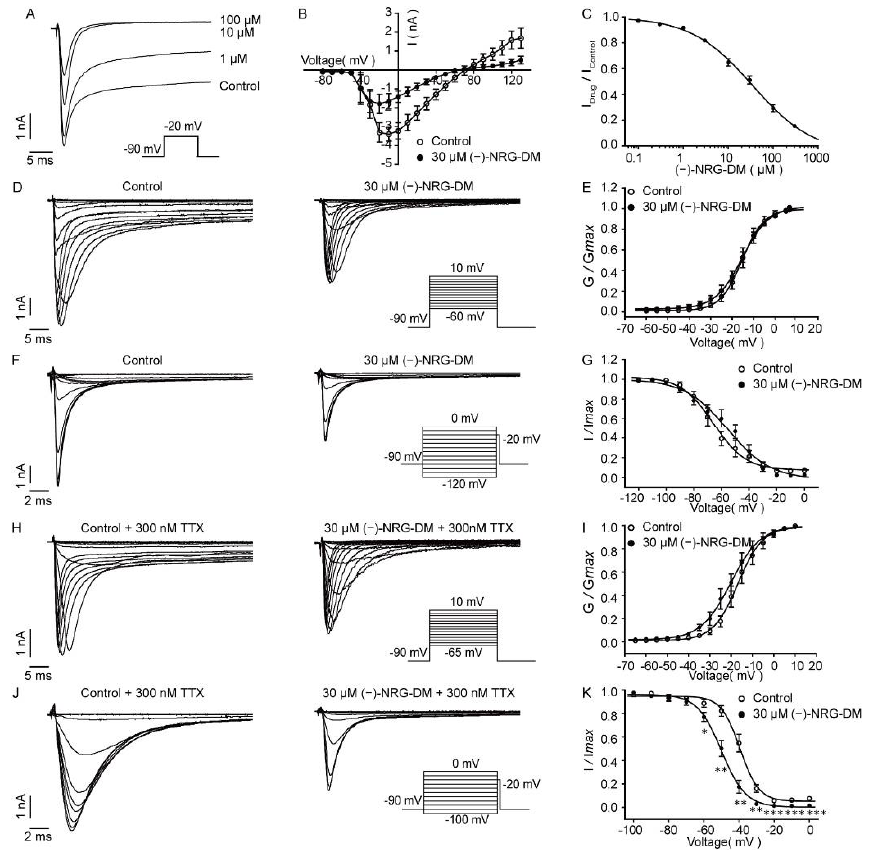
Figure 6. Characterization of ( − )-NRG-DM inhibition on Nav currents of DRG neurons in mice. ( A ) Representative traces of Nav currents in the absence or presence of ( − )-NRG-DM at indicated concentrations. ( B ) Current–voltage relationship of Nav currents with or without 30 µ M ( − )-NRG-DM ( n = 8). ( C ) The dose–response curve of ( − )-NRG-DM on native Nav currents. The IC 50 value was 34.78 ± 0.14 µ M ( n = 5). Typical activation current traces ( D ) and steady-state activation curves ( E ) of total Nav currents before and after application of 30 µ M ( − )-NRG-DM ( n = 6). Representative inactivation traces ( F ) and steady-state inactivation curves ( G ) of total Nav currents before and after perfusion of 30 µ M ( − )-NRG-DM ( n = 6). Typical activation current traces ( H ) and steady-state activation curves ( J ) of TTX-R currents before and after perfusion of 30 µ M ( − )-NRG-DM ( n = 7). Representative inactivation traces ( I ) and steady-state inactivation curves ( K ) of TTX-R currents before and after perfusion of 30 µ M ( − )-NRG-DM ( n = 7). Statistical significance: * p ≤ 0.05, ** p ≤ 0.01, *** p ≤